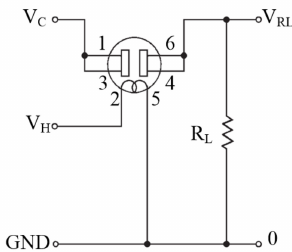
Figure 2. Circuit schematic of TGS826 referred from product manual of Figaro Ltd.